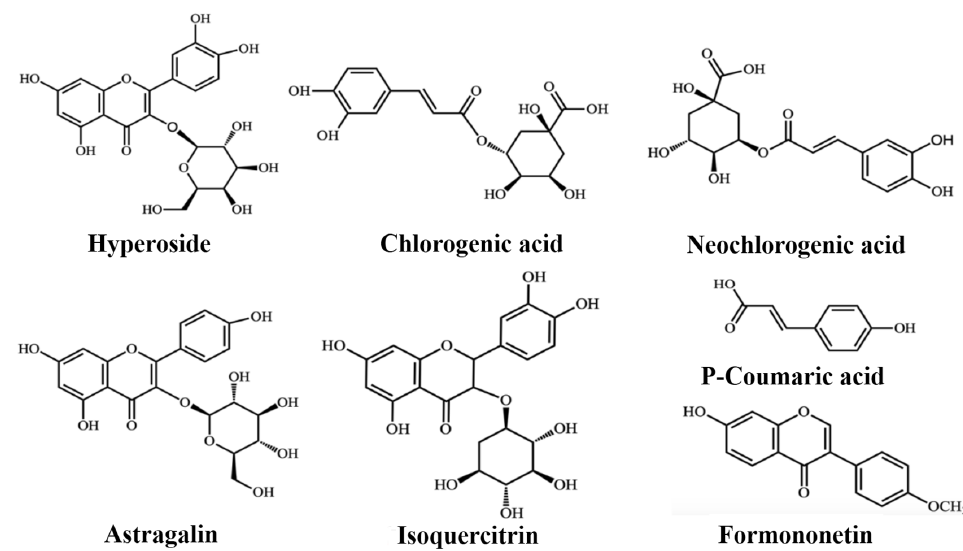
Figure 1. Chemical structures of hyperoside, chlorogenic acid, neochlorogenic acid, astragalin, isoquercitrin, P-Coumaric acid, and formononetin (IS).